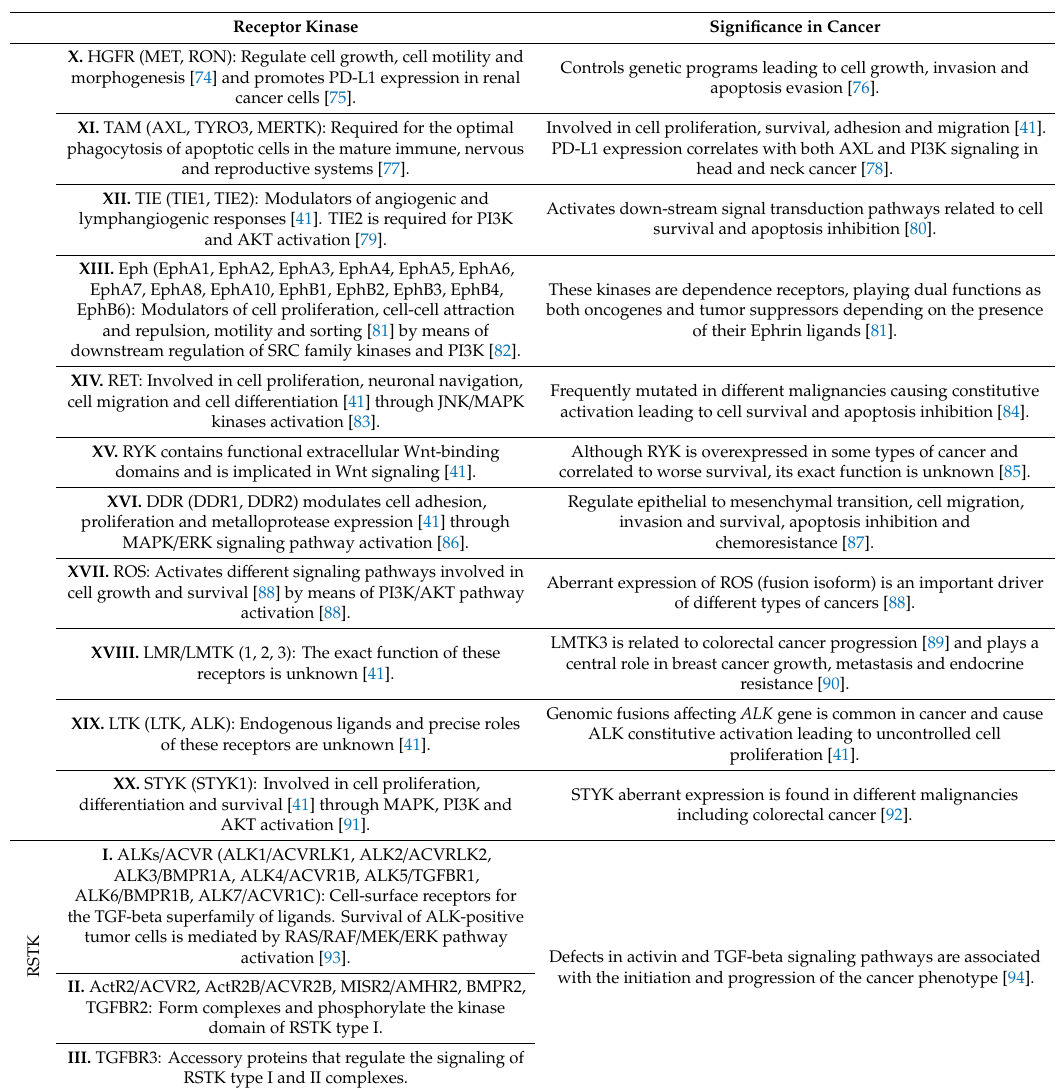
Receptor Kinase Significance in